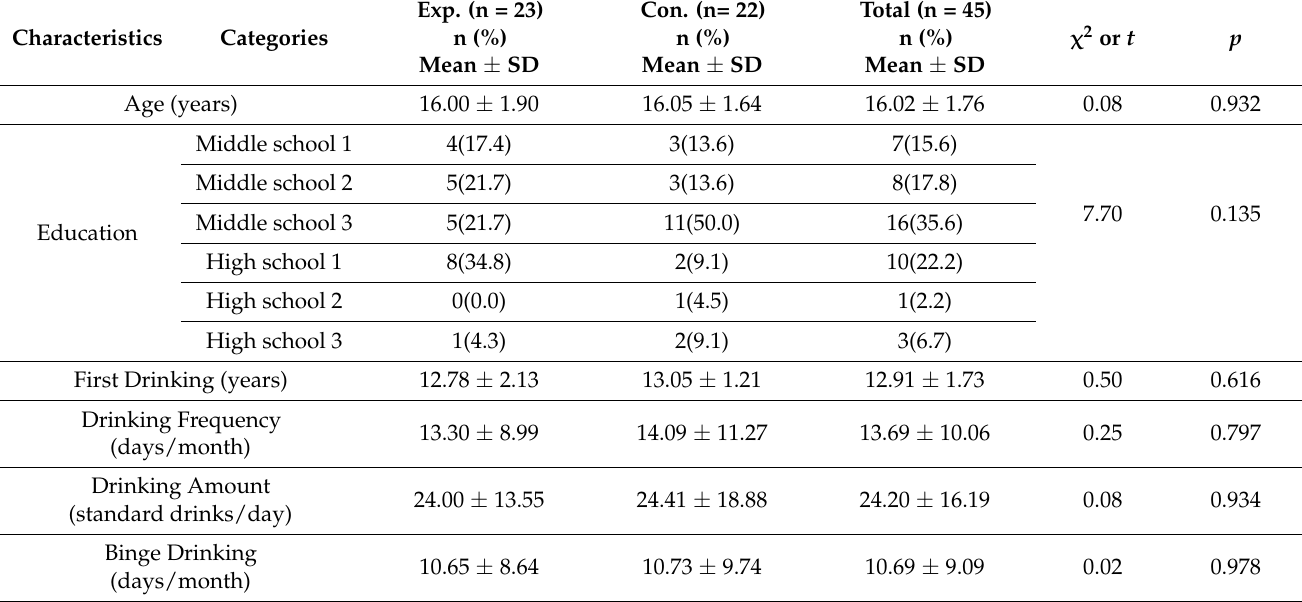
Table 3. General characteristics of the